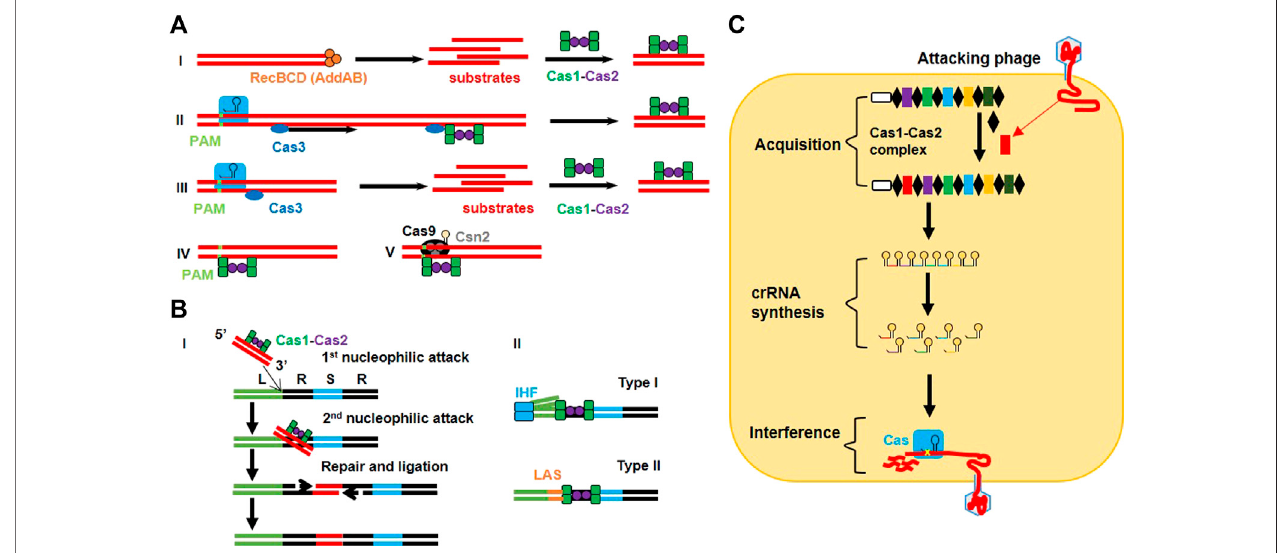
FIGURE 1 | Detailed mechanism of CRISPR immunity in bacteria. (A) Protospacer acquisition: (I) Type I naive adaptation involves nuclease/helicase RecBCD in Gram-negative organisms (or AddAB in Gram-positive organisms) to generate substrate products for the Cas1-Cas2 complex. (II) Type I nuclease-inactive Cas3 (inCas3)-primed mechanism involves a conformational change in the Cse1 subunit of Cascade after imperfect recognition of the target region that recruits inCas3. The Cas3 moves along the target strand to fi nd the suitable site where it recruits the Cas1-Cas2 complex for spacer acquisition. (III) The type I Cas3 mechanism allows Cascade to recognize foreign DNA in a PAM-dependent manner and to recruit Cas3 to generate substrate products for the Cas1-Cas2 complex. (IV) Type I Cas3- independent mechanism employs the inherent ability of the Cas1-Cas2 complex to recognize the target in a PAM-dependent manner. (V) Type II adaptation utilizes the PAM-interacting domain (PID) of Cas9 (loaded with tracrRNA) to guide the Cas1-Cas2 complex (along with accessory protein Csn2) for retrieving protospacers. (B) Spacer integration into the CRISPR array: (I) The Cas1-Cas2 complex guides the protospacer (3 ′ -OH) to execute 1st nucleophilic attack at the leader end (L) of the fi rst repeat (R). This bends the repeat DNA to help protospacer in executing 2nd nucleophilic attack at the spacer end (S) of the same repeat. As a result of these cleavage- ligation reactions, a double-stranded protospacer is bound to single-stranded repeat sequences via its 3 ′ ends. The gaps are fi lled and repaired via polymerases and ligases. (II) The type I system allows integration host factor (IHF) to bend DNA after binding to the conserved sequence in the leader region, which allows the Cas1-Cas2 complextointeractwiththeleaderandIHFtoperformthecleavage-ligationreaction.InthetypeIIsystem,recognitionoftheleaderanchoringsequence(LAS)byCas1is suf fi cient to execute polarized integration of the spacer. (C) Sequential phage interference: CRISPR immunity consists of three steps. The acquisition step involves integration of the new spacer (red) between the two repeat elements (black) with the help of the Cas1-Cas2 complex. crRNA synthesis step involves the transcription of the CRISPR array from the leader sequence (white) to make pre-crRNA which is further converted into a series of crRNAs. During the interference step, crRNA is assembled with the Cas protein (blue) to make the effector complex that targets and cleaves the complementary sequence in the genome of the attacking phage.